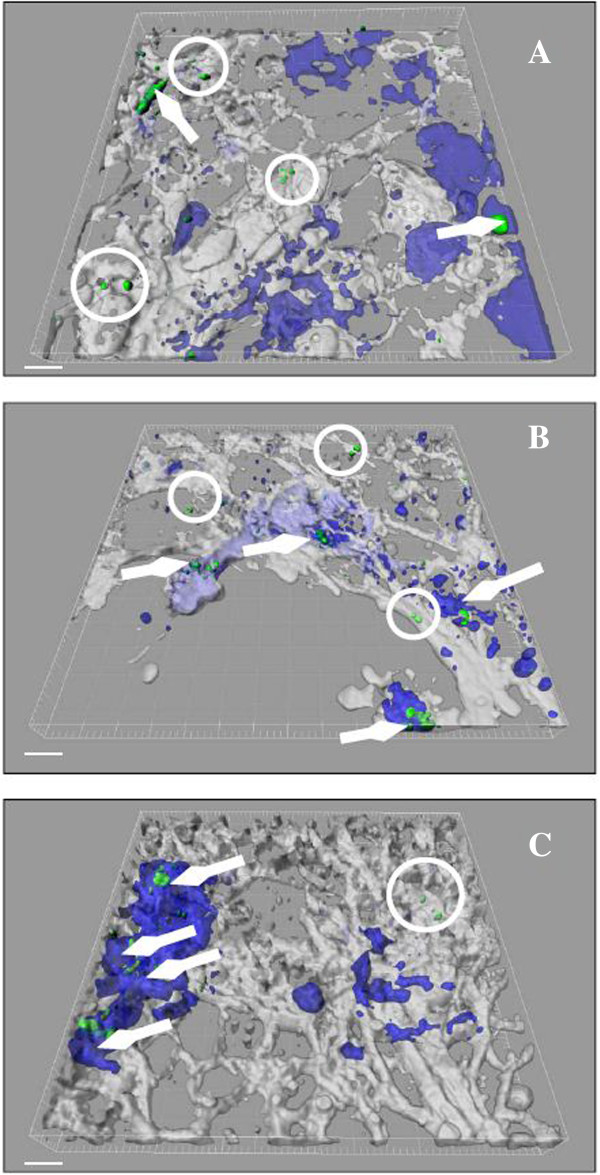
Visualisation of NP uptake in the apical part of the triple cell culture model (actin, white; macrophages, blue; nanoparticles, green). The pictures represent 3D renderings of the complete data set and the actin as well as the macrophage labeling was made transparent to show intracellular nanoparticles. A) unloaded CTC NP, B)CTC pGFP NP and C)CTPPC pGFP NP. Arrows indicate internalised NP into MDM; extracellular NP are encircled. White bar represents a 20 μm scale.